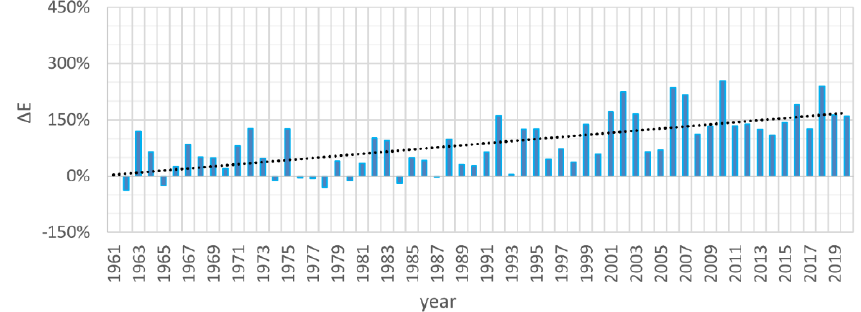
Figure 7. Relative energy for air cooling compared to 1961.